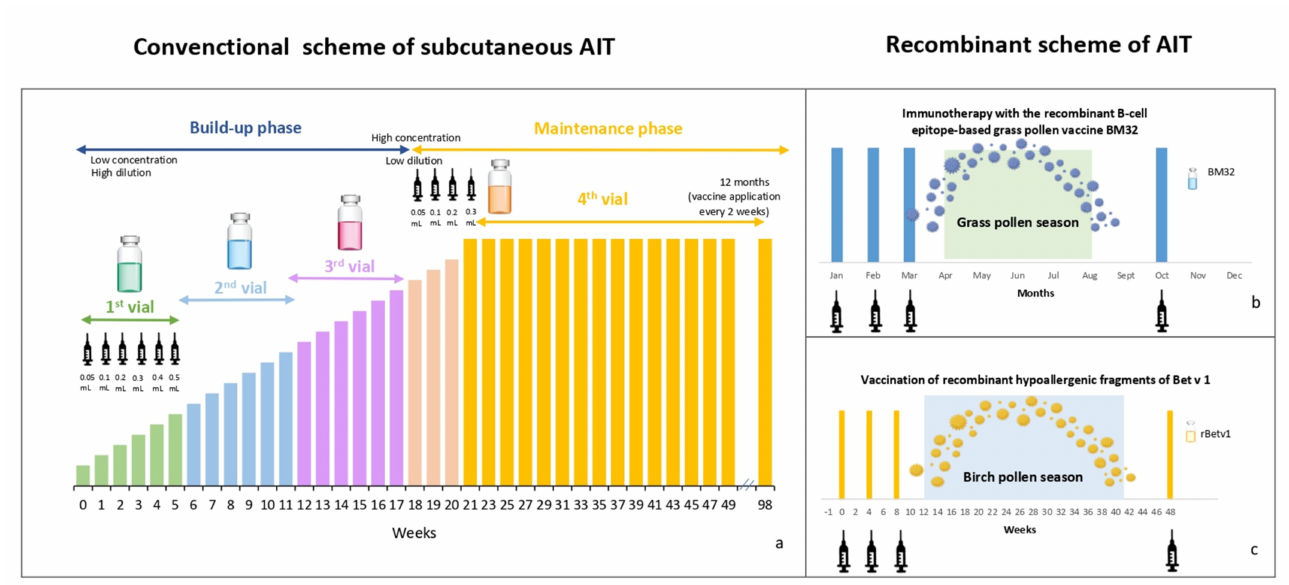
Figure 1. Schemes of allergen immunotherapy. ( a ) Classical subcutaneous immunotherapy scheme consisting of build-up and maintenance phase. ( b ) Recombinant scheme with grass ( c ) Recombinant scheme with birch